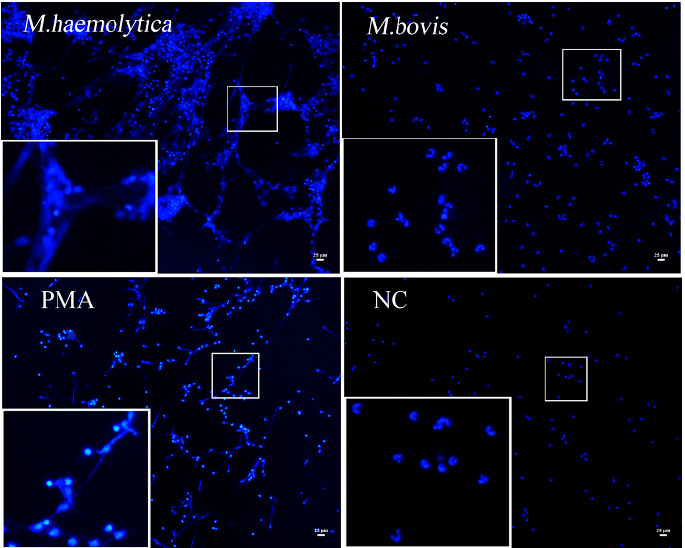
Figure 3. Neutrophil extracellular traps (NETs) formation induced by different stimulators. NETs were induced by Mannheimia haemolytica ( M. haemolytica ) (MOI = 100) and 200 nM phorbol 12-myristate 13-acetate (PMA), but not by M. bovis HB0801 strain (MOI = 1000). PBS treatment was taken as the negative control. Extra- and intracellular DNA was stained blue by DAPI (magnifications: ×100; the zoomed images in the lower left boxes are ×3 magnifications of the images in middle small boxes).